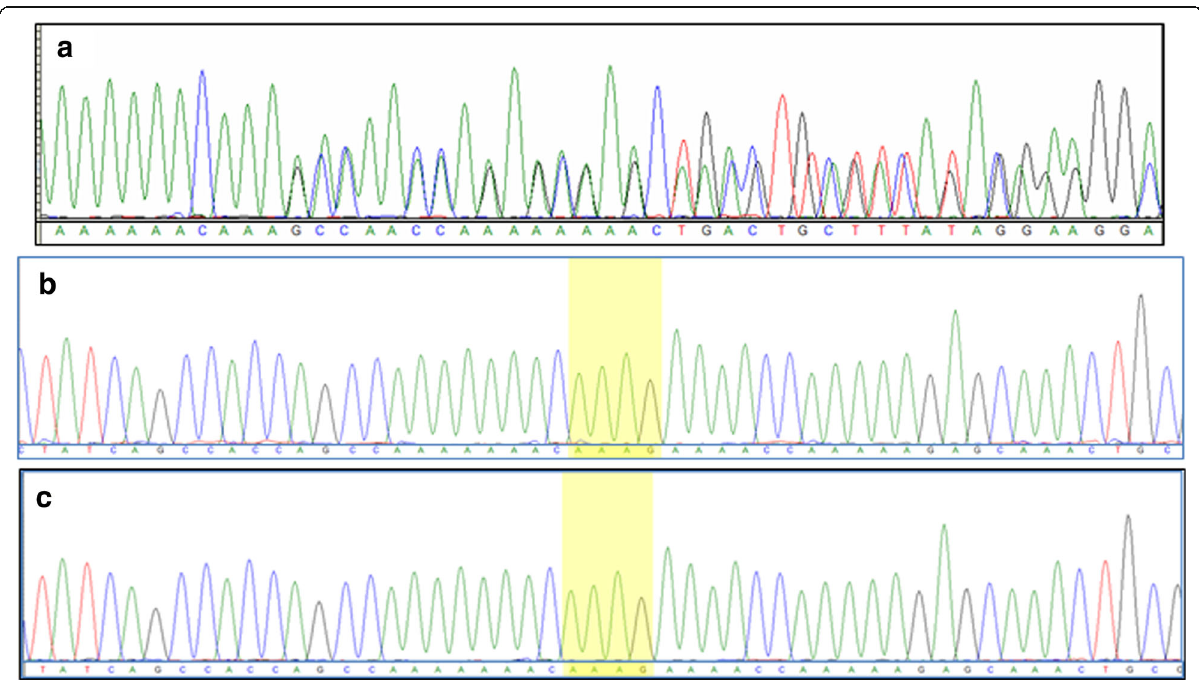
Fig. 2 Sequence chromatograms showing the novel CTCF frameshift mutation in a heterozygous state in the patient; Panel ( a ). Both parents were found to harbor wild type CTCF ; Panels ( b ) and ( c ), in which the AAAG that is deleted by the mutation is